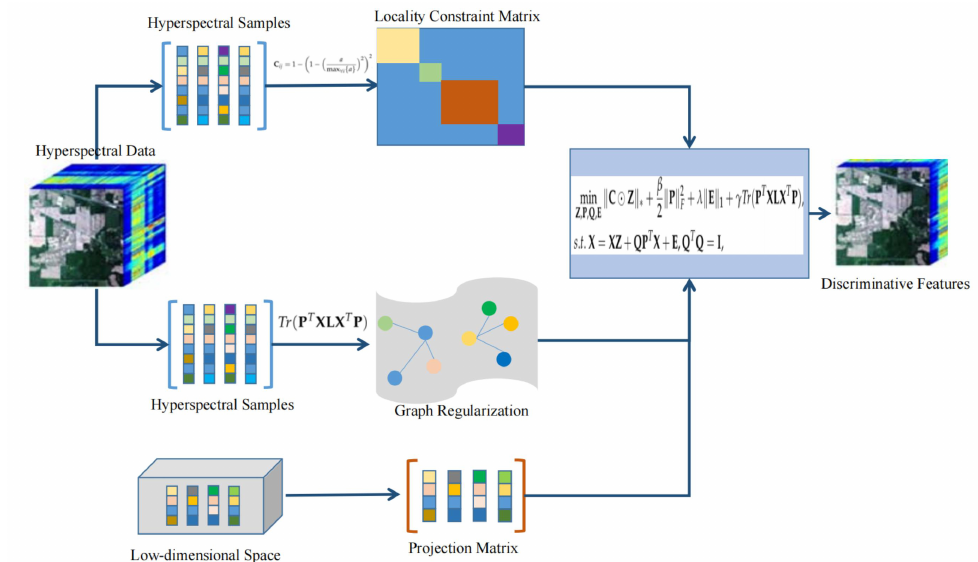
Figure 1. The framework of the proposed LatLRPL